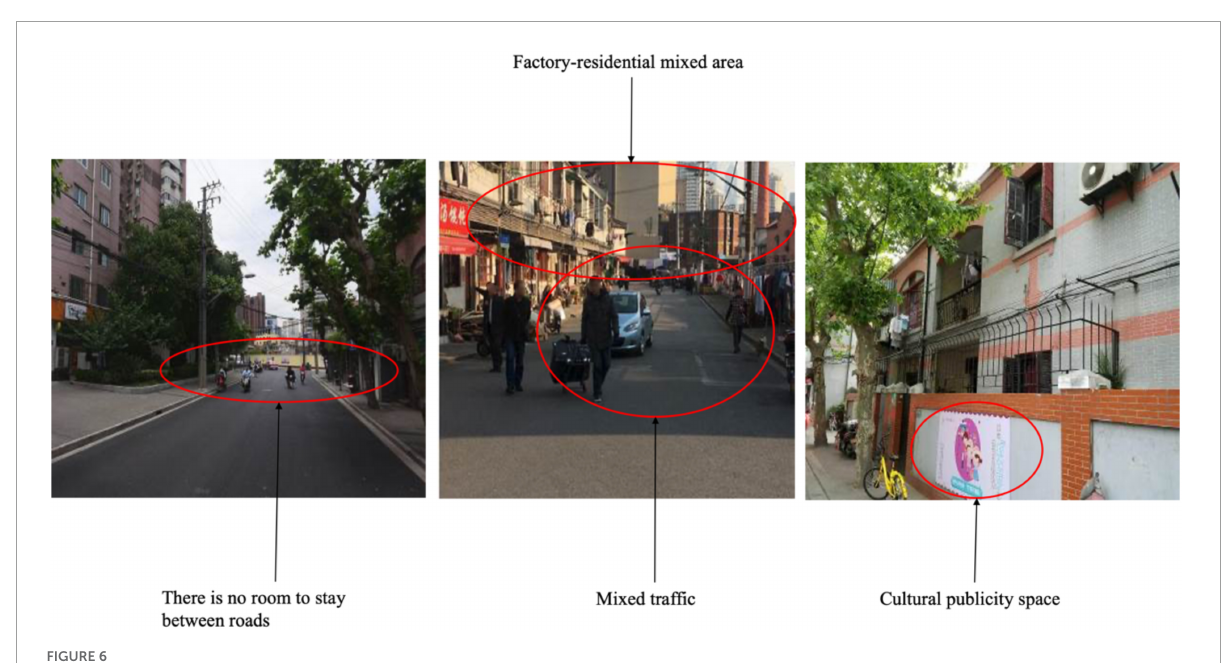
FIGURE6 Street view of Hailun Road (Source: